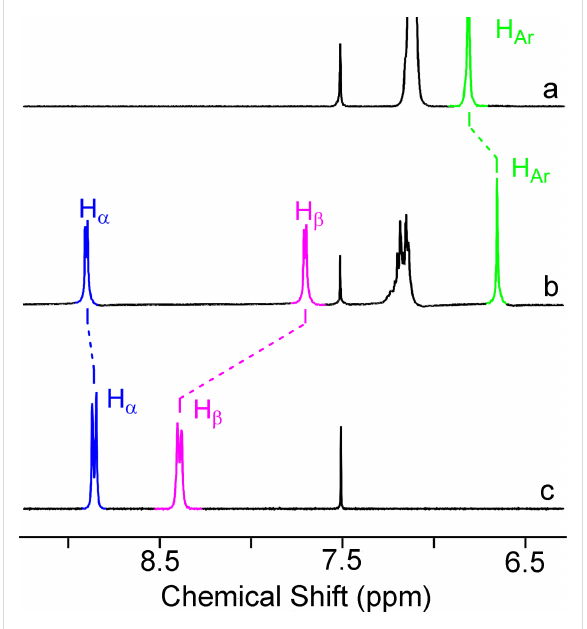
Figure 3: Partial 1 H NMR spectra (300 MHz, CD 3 CN/CDCl 3 4:3, v/v) of (a) free host 3 , (b) 3 and 1.0 equiv of 7 , and (c) free guest 7 .